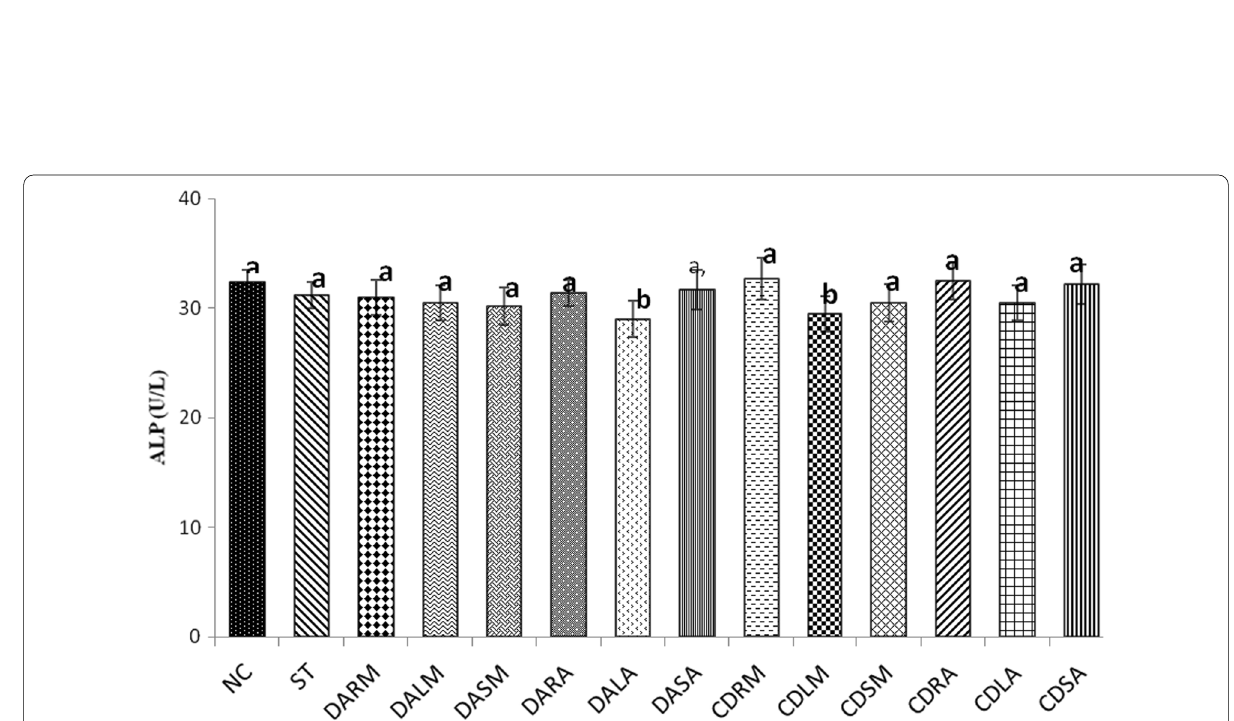
Fig. 11 Effects of administration of methanolic and aqueous extracts of roots, leaves and stem of D. arborescens and C. dependens on Alkaline phosphatase (ALP) of albino rats. Bars with similar alphabets are not statistically different ( p <